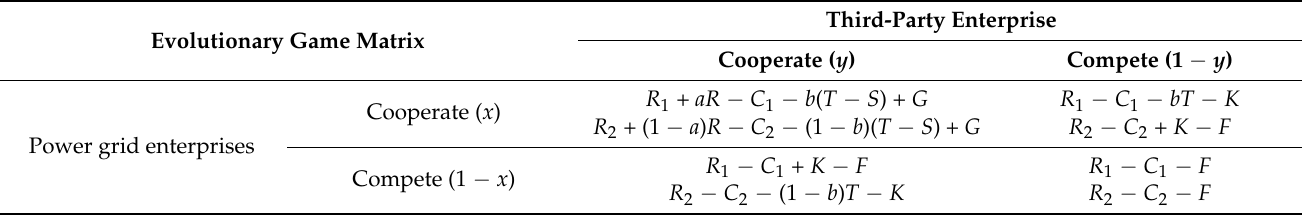
Table 1. Evolutionary game matrix of both parties under government supervision.